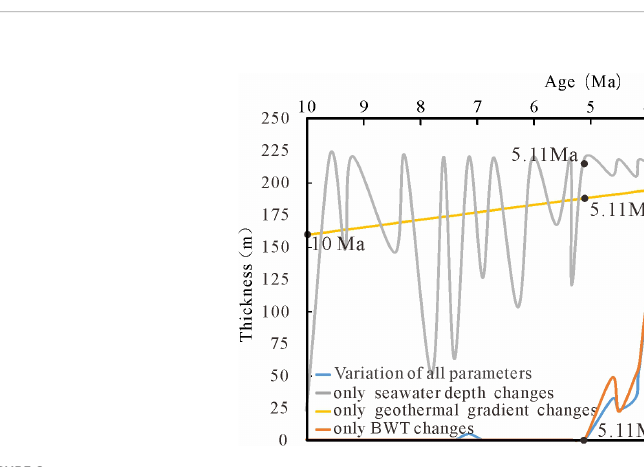
FIGURE 8 Effects of the geothermal gradient, BWT and seawater depth on the thickness of the GHSZ since 10